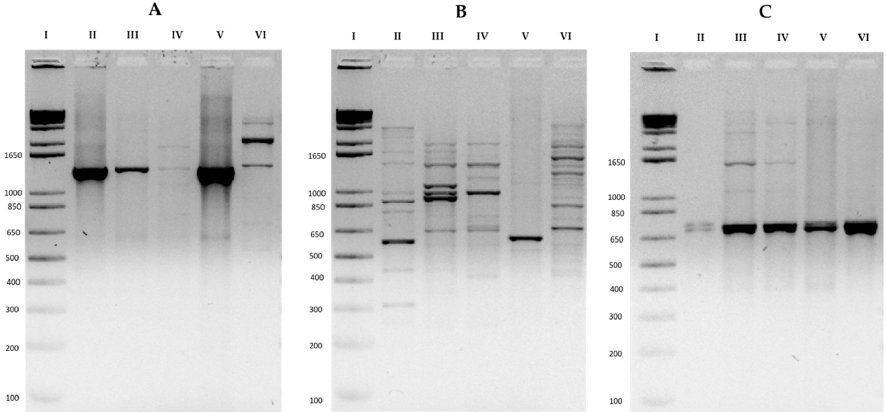
Figure 2. Agarose gel electrophoresis of the biosynthetic gene amplification products. ( A ) 1200–1400 bp fragments of polyketide synthase I (PKS-I) genes, ( B ) 800 to 900 bp fragments of type II polyketide synthase (PKS-II) genes, and ( C ) 700 bp fragments of non-ribosomal peptide synthase (NRPS) genes. Lane, I: 1 kb molecular weight marker; lane II: Streptomyces parvisporogenes (S2A-04); lane III: Streptomyces manipurensis (S3A-05); lane IV: Streptomyces manipurensis (S3A-09); lane V: non-active strain Streptomyces